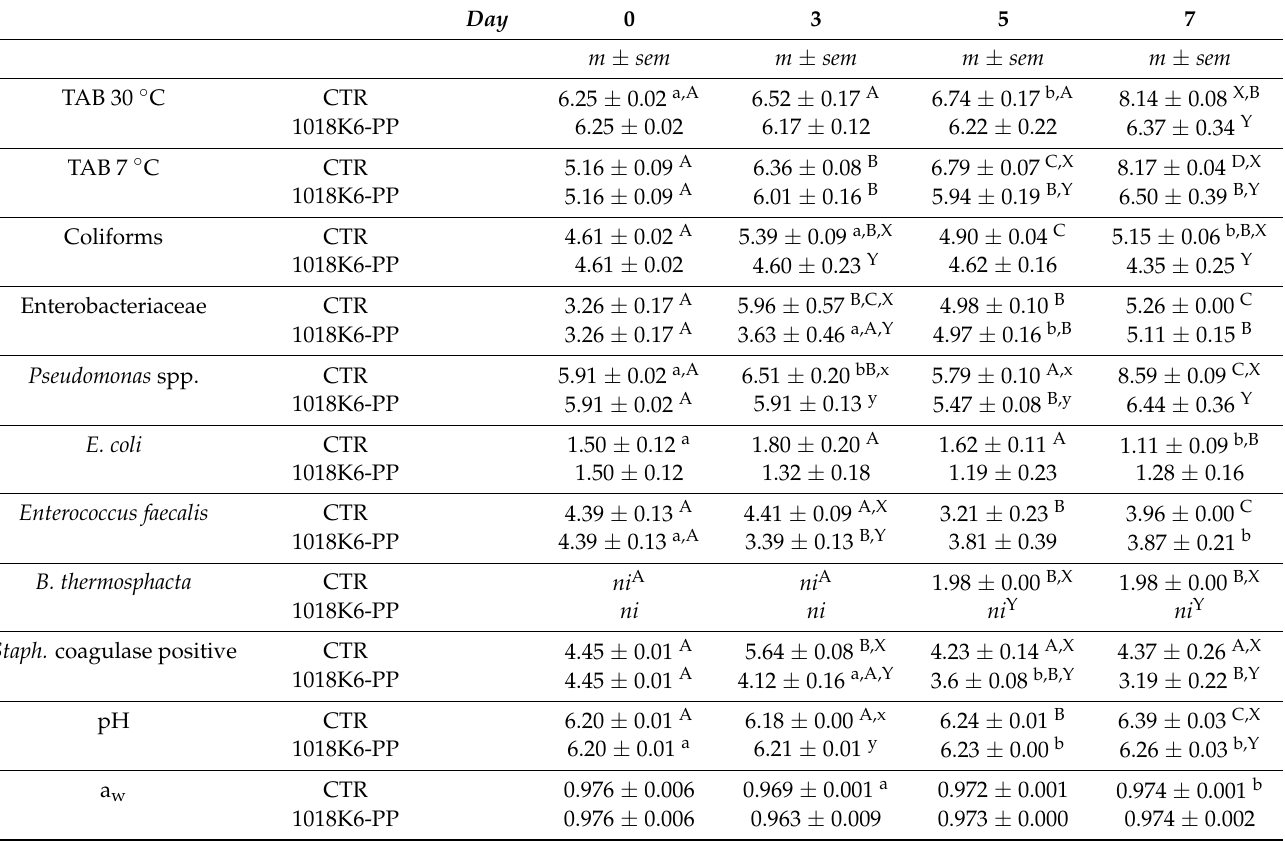
Table 3. Evaluation of microbiological counts (Log CFU/g) in Sarda sarda burgers packaged in active PP films functionalized with 1018K6 by storage